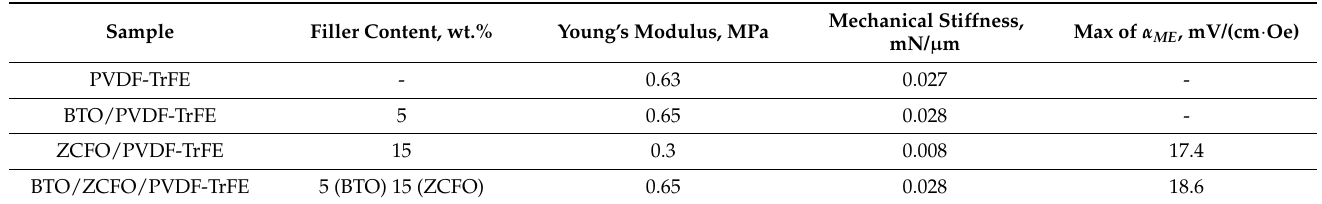
Table 2. Concentration, mechanical and magnetoelectric parameters for the studied